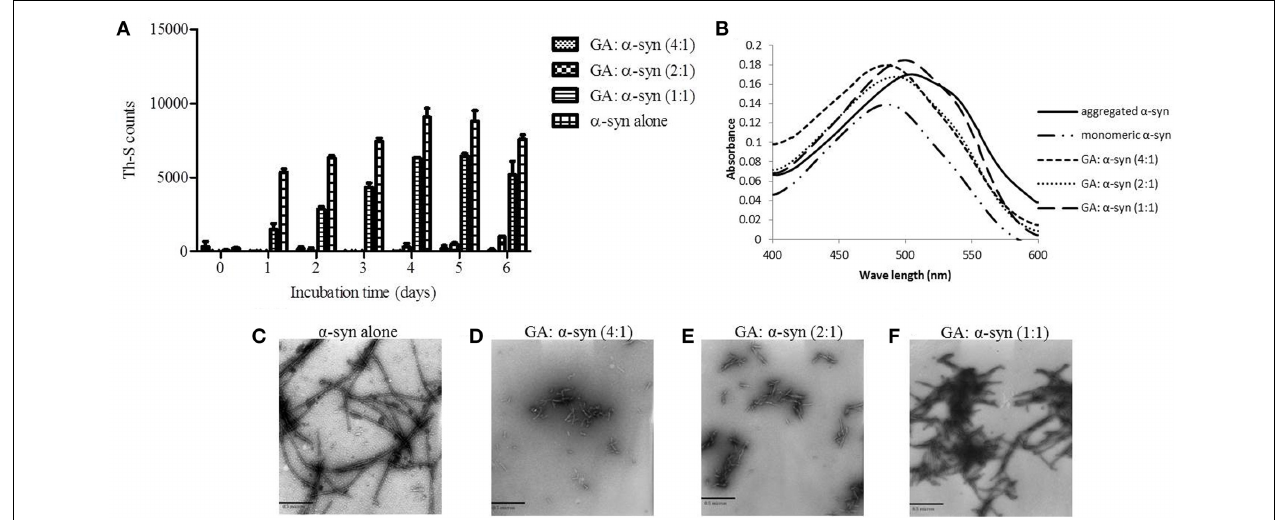
FIGURE 1 | GA inhibits α -syn fibrillation in a concentration-dependent manner. (A) Samples of α -syn (25 μ M) were incubated alone or in the presence of GA (molar ration of GA: α -syn 4:1, 2:1, 1:1) for 6 days with continuous shaking at 37 ◦ C. Fibril formation was estimated by Th-S fluorescence. The assay was performed in triplicate (average of triplicate measurement ± standard deviation). (B) Congo red binding for samples of α -syn (25 μ M) incubated alone or in the presence of GA (molar ratio of GA: α -syn 4:1, 2:1, 1:1) for 6 days with continuous shaking at 37 ◦ C. Samples of α -syn (5 μ M) aged alone or with GA were mixed with Congo red at a final